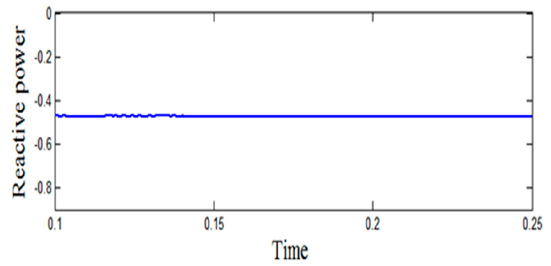
Figure 29. Real power from generation.